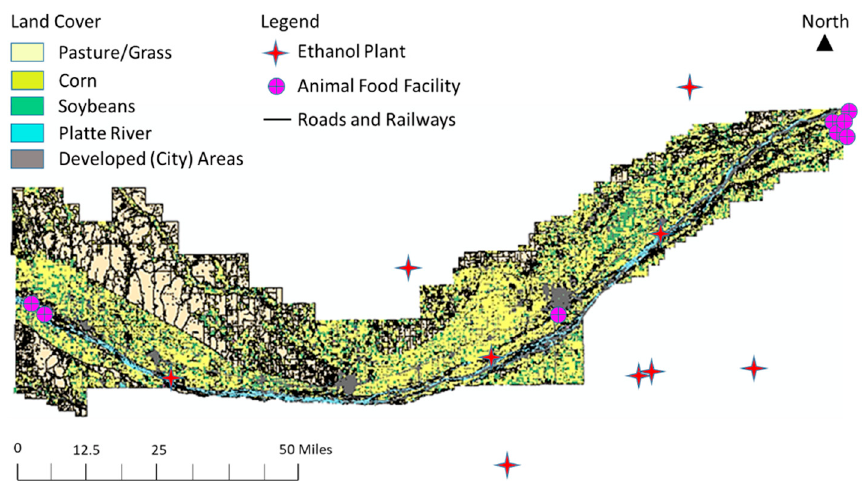
Figure 2. Land cover and locations of ethanol plants and animal food facilities. (Source: USDA’s Cropland Data Layer—Metadata, 2014) [36].